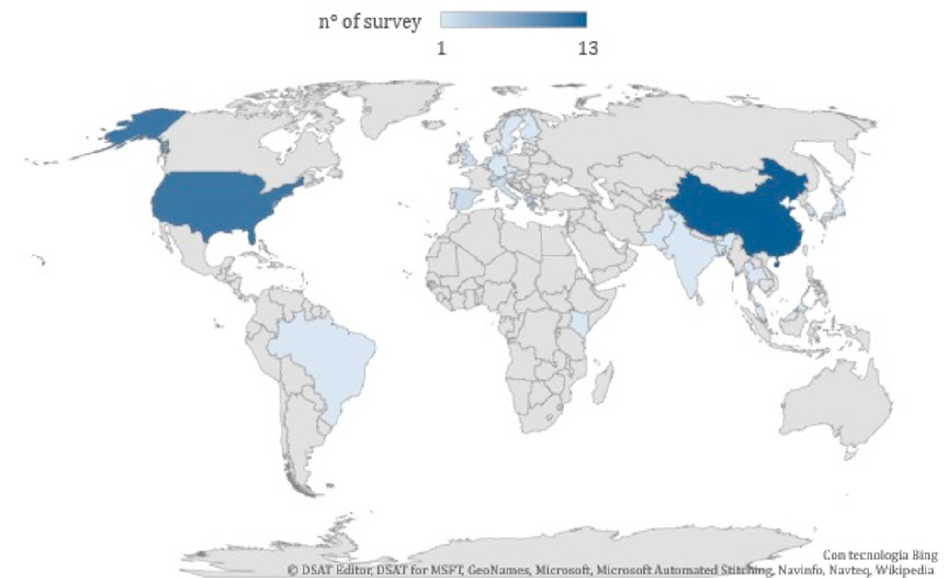
Figure 2. Geographical distribution of the studies included in the systematic review.